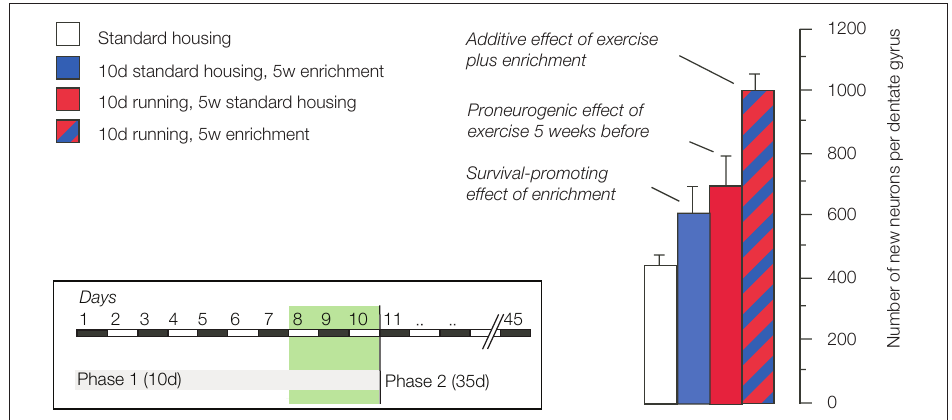
Figure 1 | The schematic summarizes the experimental design and the key finding of our study on the additive effects of exercise and environmental enrichment on adult neurogenesis (Fabel et al., 2009